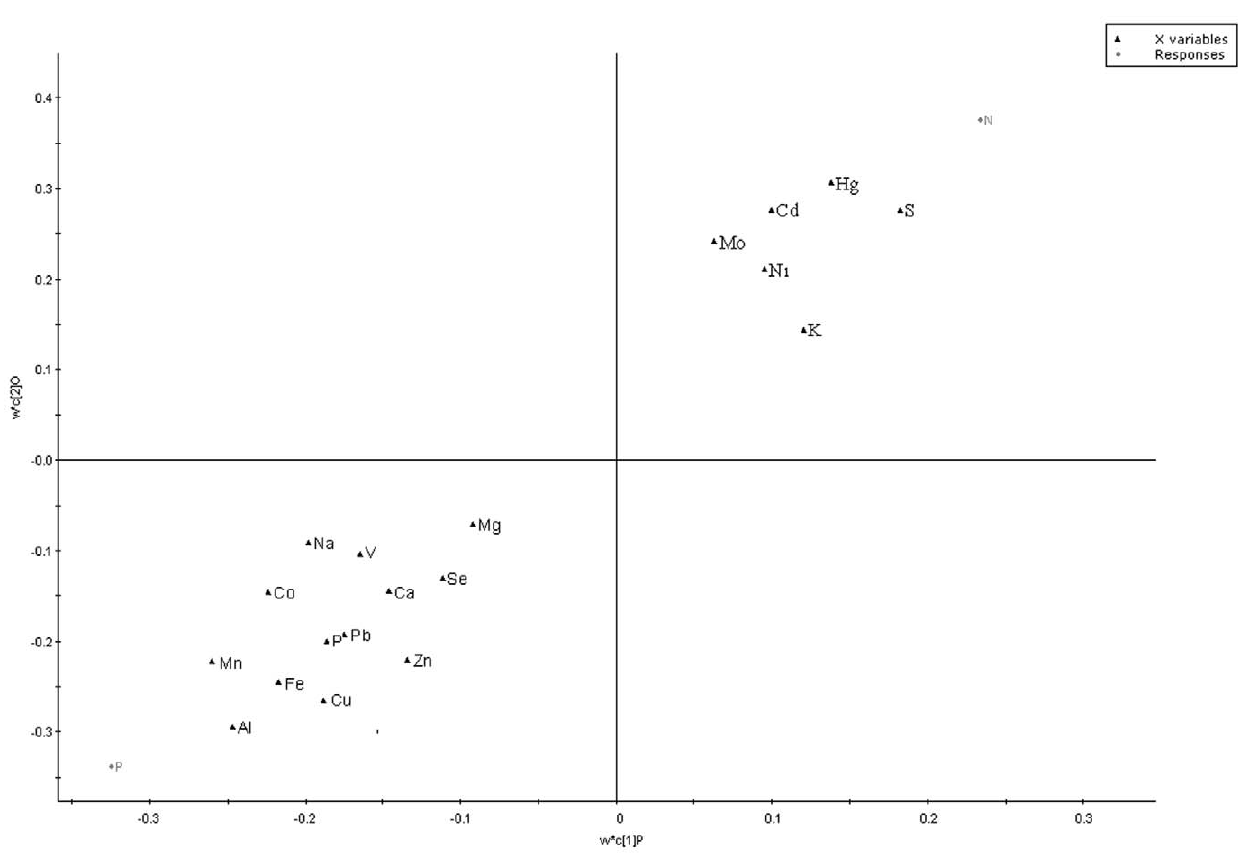
Figure 2. Biomarker detection: Elements which are dominating the separation of disease from normal. The loading coefficient map showing that aluminum, copper, iron, manganese, and zinc were predominantly responsible for the classification of groups. The blackened triangle represents elements; grey circle represents normal (N) and Parkinson’s disease (P).